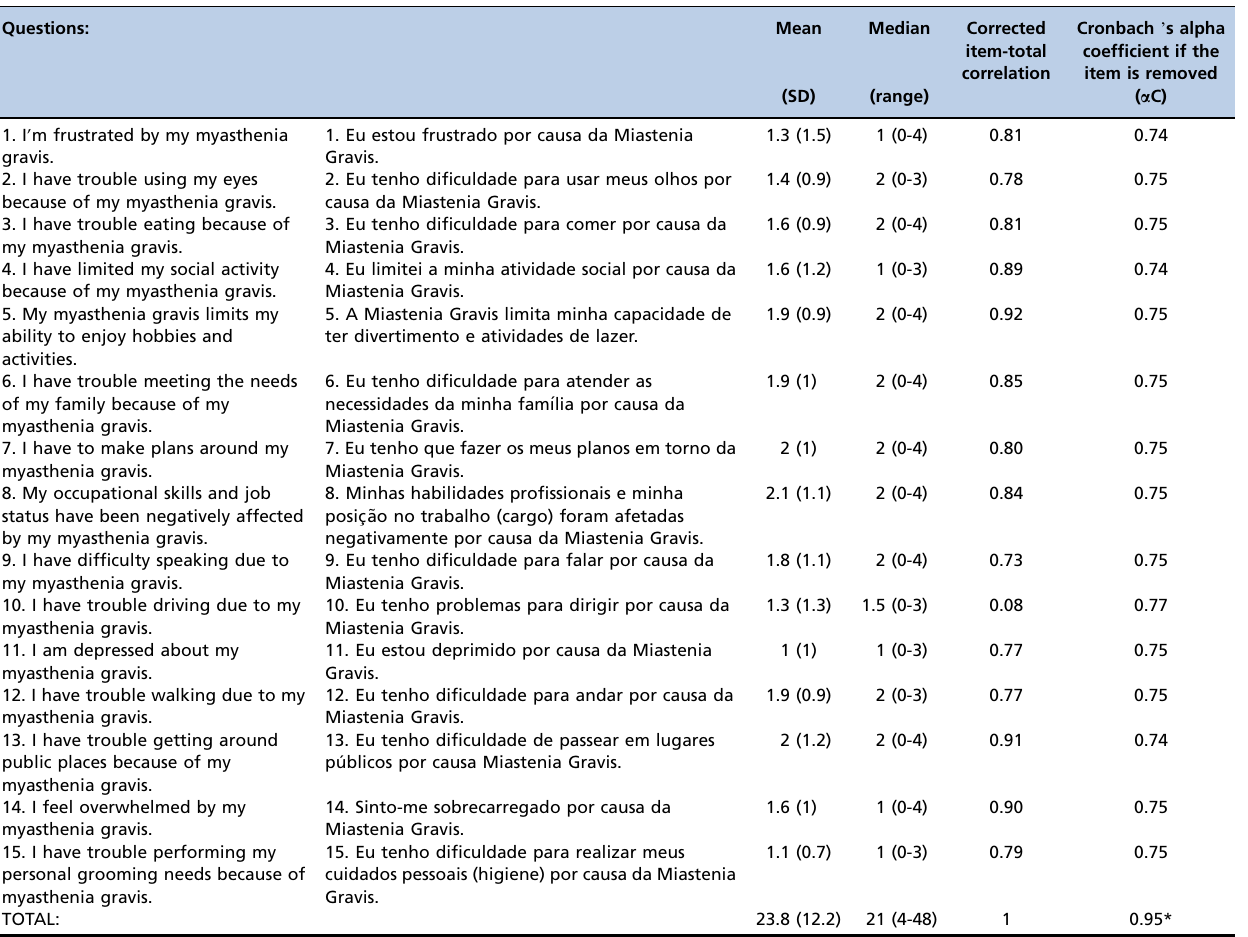
Table 2 - Mean score and internal reliability of the Brazilian-Portuguese version of